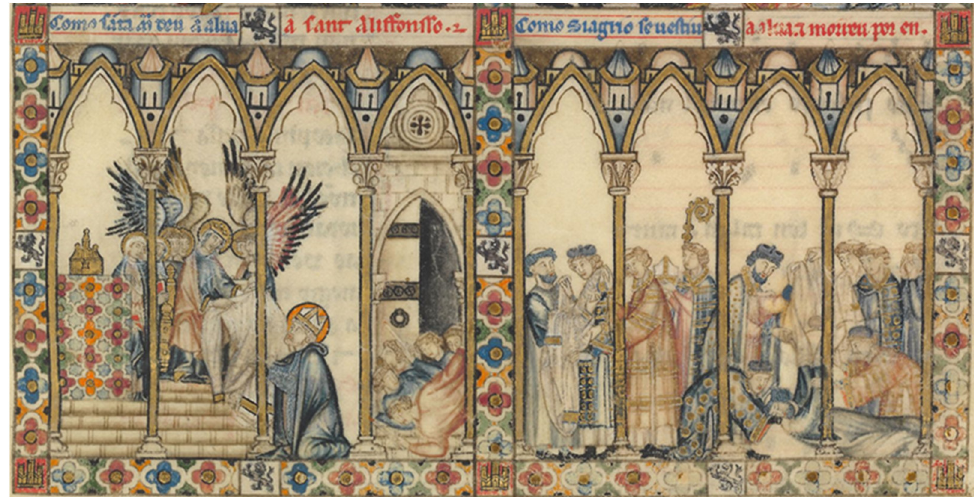
Figure 1. Como Santa Maria deu a alva/a Sant’Alifonso et Como Siágrio se vestiu/a alva, e morreu porém (“How St. Mary gave the chasuble to St. Ildefonsus and how Siagrio put on and as a result, he died”). Alfonso X de Castilla (el Sabio), Cantigas de Santa María , Códice Rico Ms. T-I-1, f. 7r (1280–1284), Real Biblioteca del Monasterio de San Lorenzo de El Escorial, © Patrimonio Nacional.